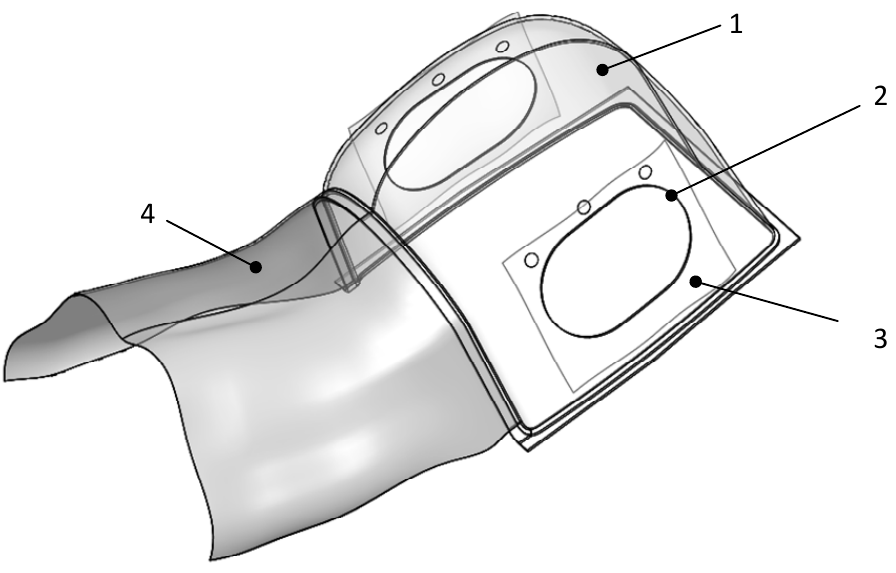
Figure 1. Device used in the study: ( 1 ) hard plastic bubble; ( 2 ) side openings; ( 3 ) flexible transparent plastic curtain; and ( 4 ) flexible plastic extension blanket. As shown in ( 1 ), this device has a semi- spherical shape that provides ease of disinfection by the specialized teams in hospitals. Structures ( 1 ), ( 2 ), and ( 3 ) point to a suitable shape, a transparent structure, and an opening selected to avoid the feeling of claustrophobia in patients suffering from respiratory insufficiency (the object of study of this experimental project). In ( 4 ), a structure designed to provide greater protection to the patient and to the healthcare worker can be observed.